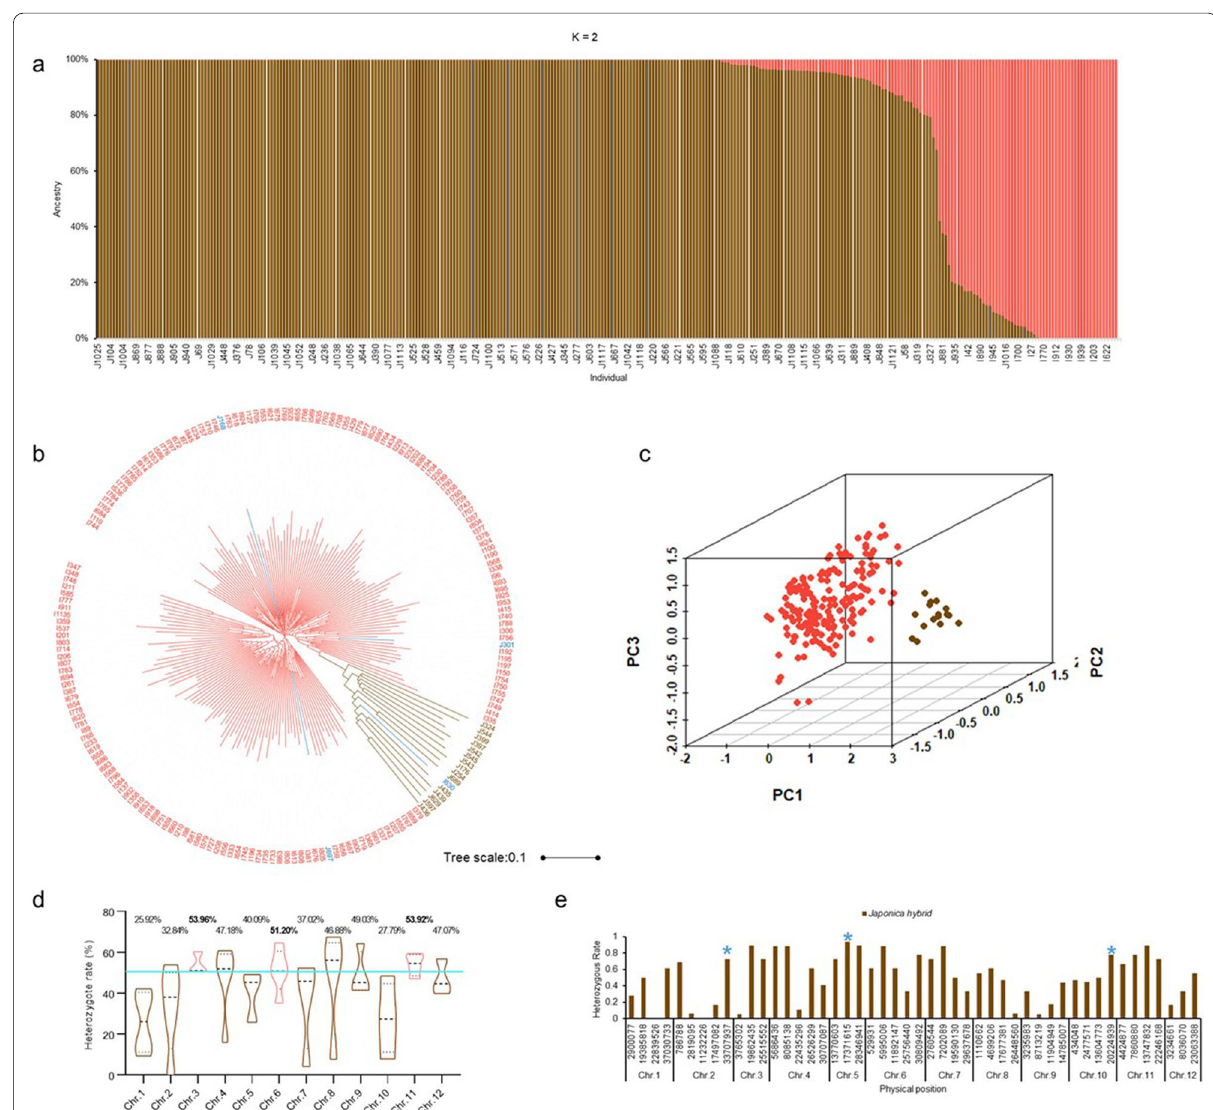
Fig. 5 Analysis of the 48 KASP markers in hybrid varieties. a – c The phylogenetic tree, population structure and PCA of the hybrid varieties using 48 KASP markers. d The heterozygous rate of each chromosome. e The heterozygous rate of japonica hybrid variety. The blue star indicated three sites with higher heterozygous rate. The brown indicated the japonica varieties while light red represented the indica varieties in b . The blue indicated that the varieties with the classification of the phylogenetic tree different from the original annotation coming from the breeding institutes in b . The brown indicated the subpopulation 1while light red represented subpopulation 2 in